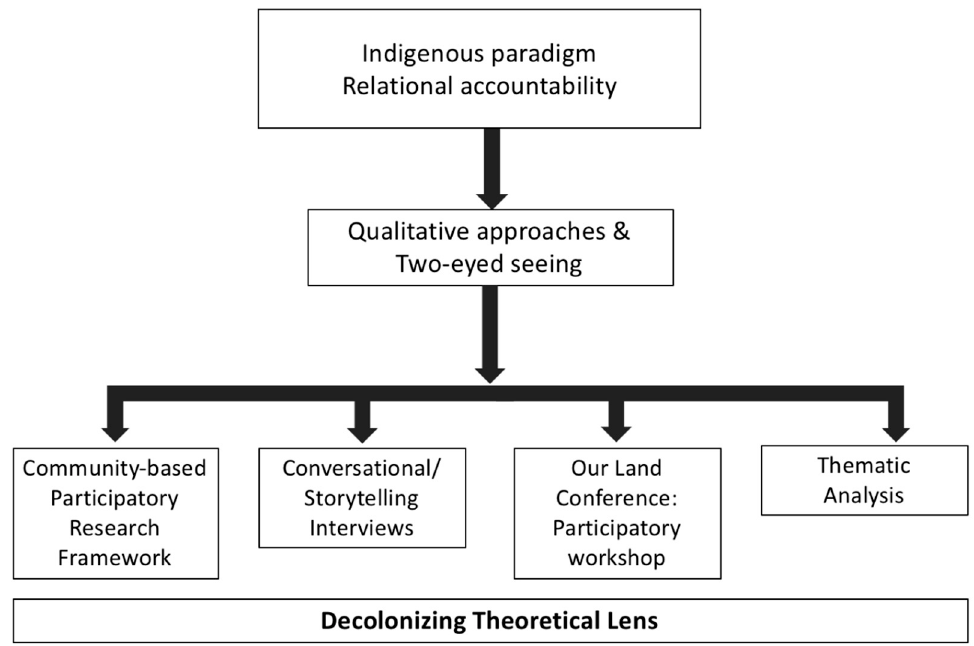
Figure 1. Overview of project design and Indigenous approach to inquiry.